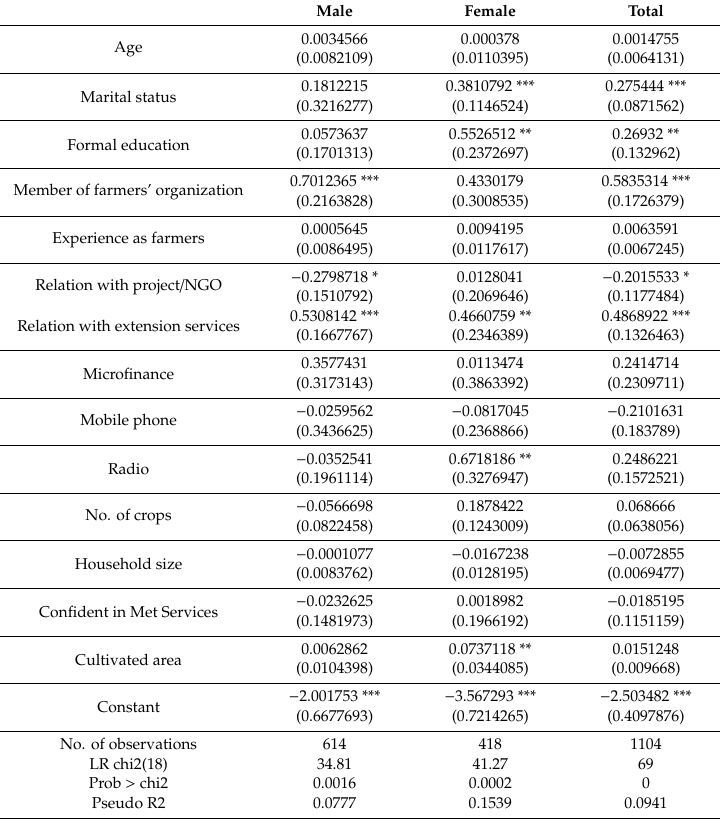
Table 11. Determinants of the use of